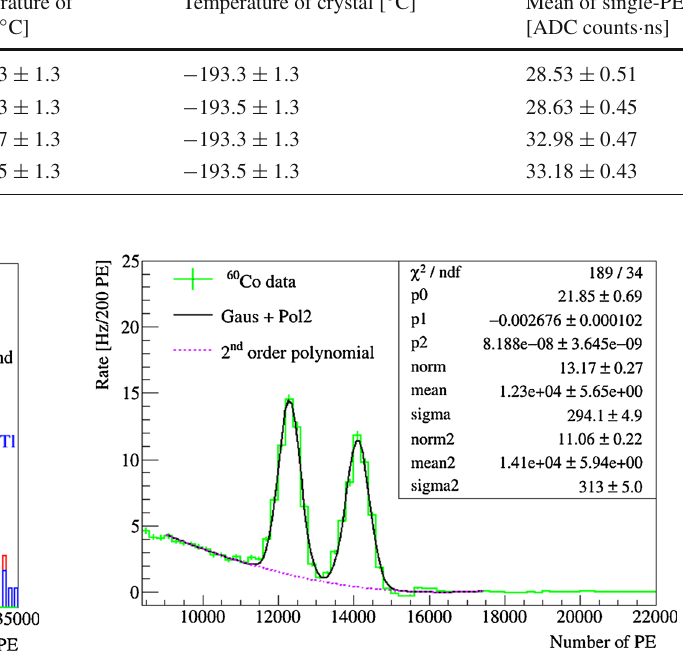
Fig. 8 Energy spectrum recorded by the bottom PMT at 80 K with a 60 Co source. The clearly separated peaks were fitted simultaneously with two Gaussian distributions on top of a 2 nd order polynomial rated indicating an energy resolution much better than